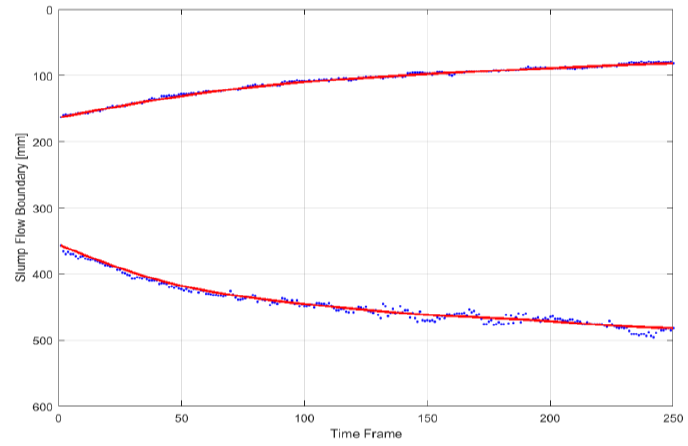
Figure 15. Detected boundaries of slump flow on the 4D slump image.